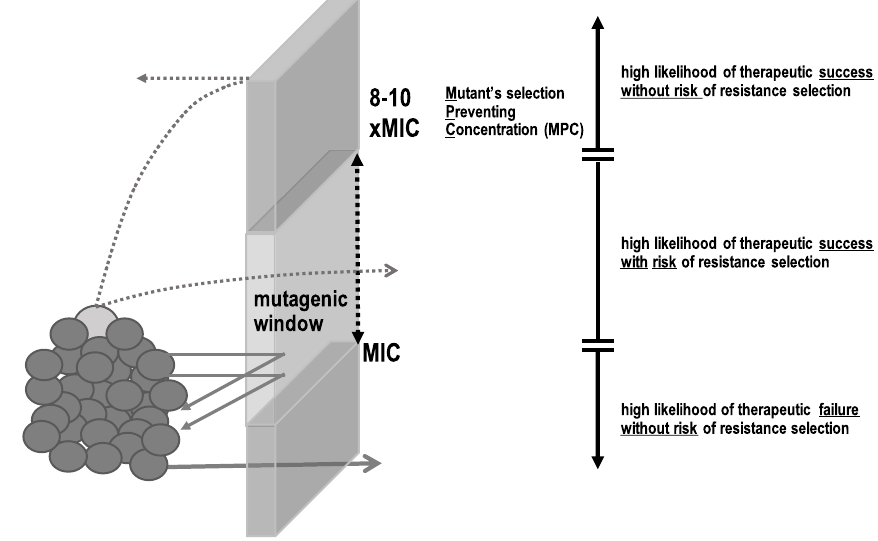
Fig. 2 Descriptive definition of the mutant preventing concentration and mutagenic